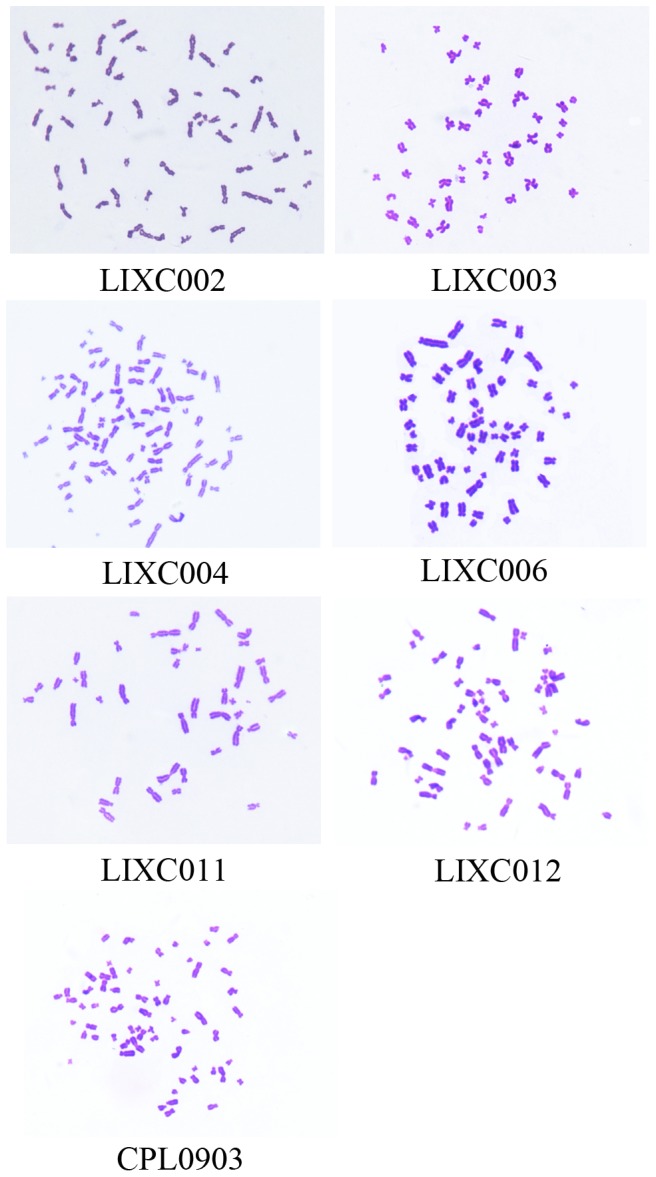
Chromosome analysis of 7 new HCC cell lines.The median centromere showed human cell origin. Magnification, ×1000.